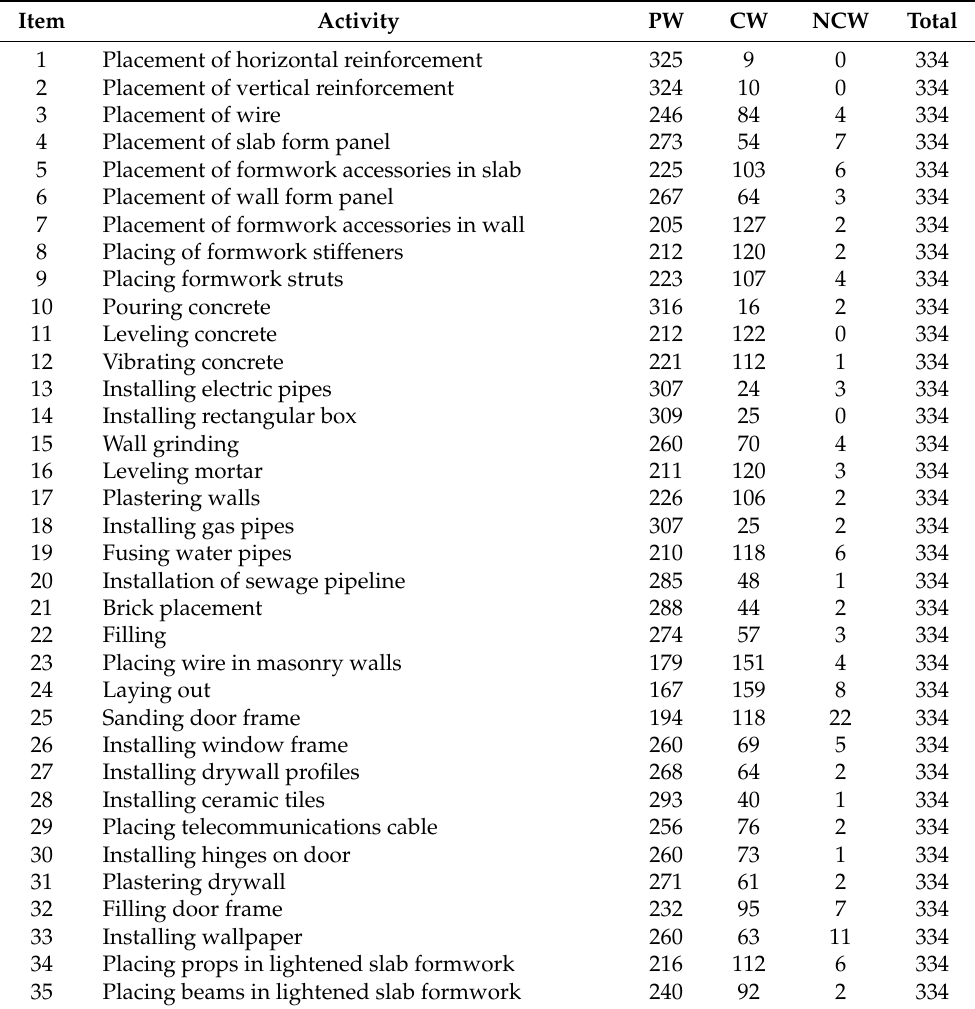
Table 2. Results of the survey taken to classify productive, contributory, and noncontributory